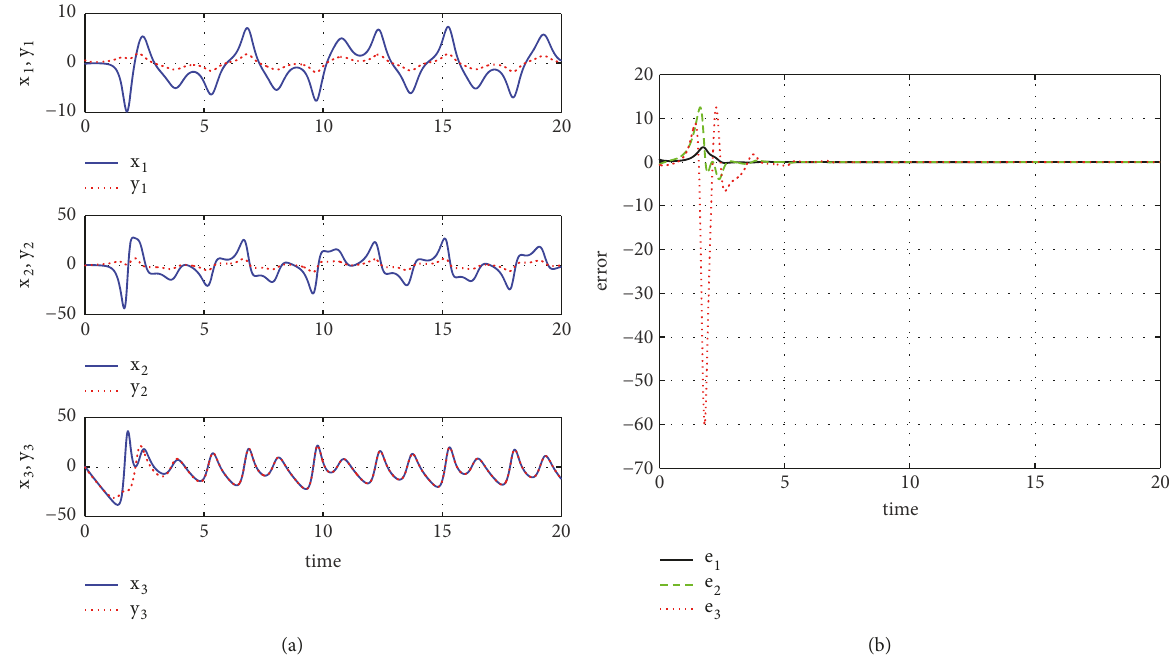
Figure 6: Partial projective synchronization with k 2 =3.3; k 3 =0.6: (a) time response; (b) synchronization